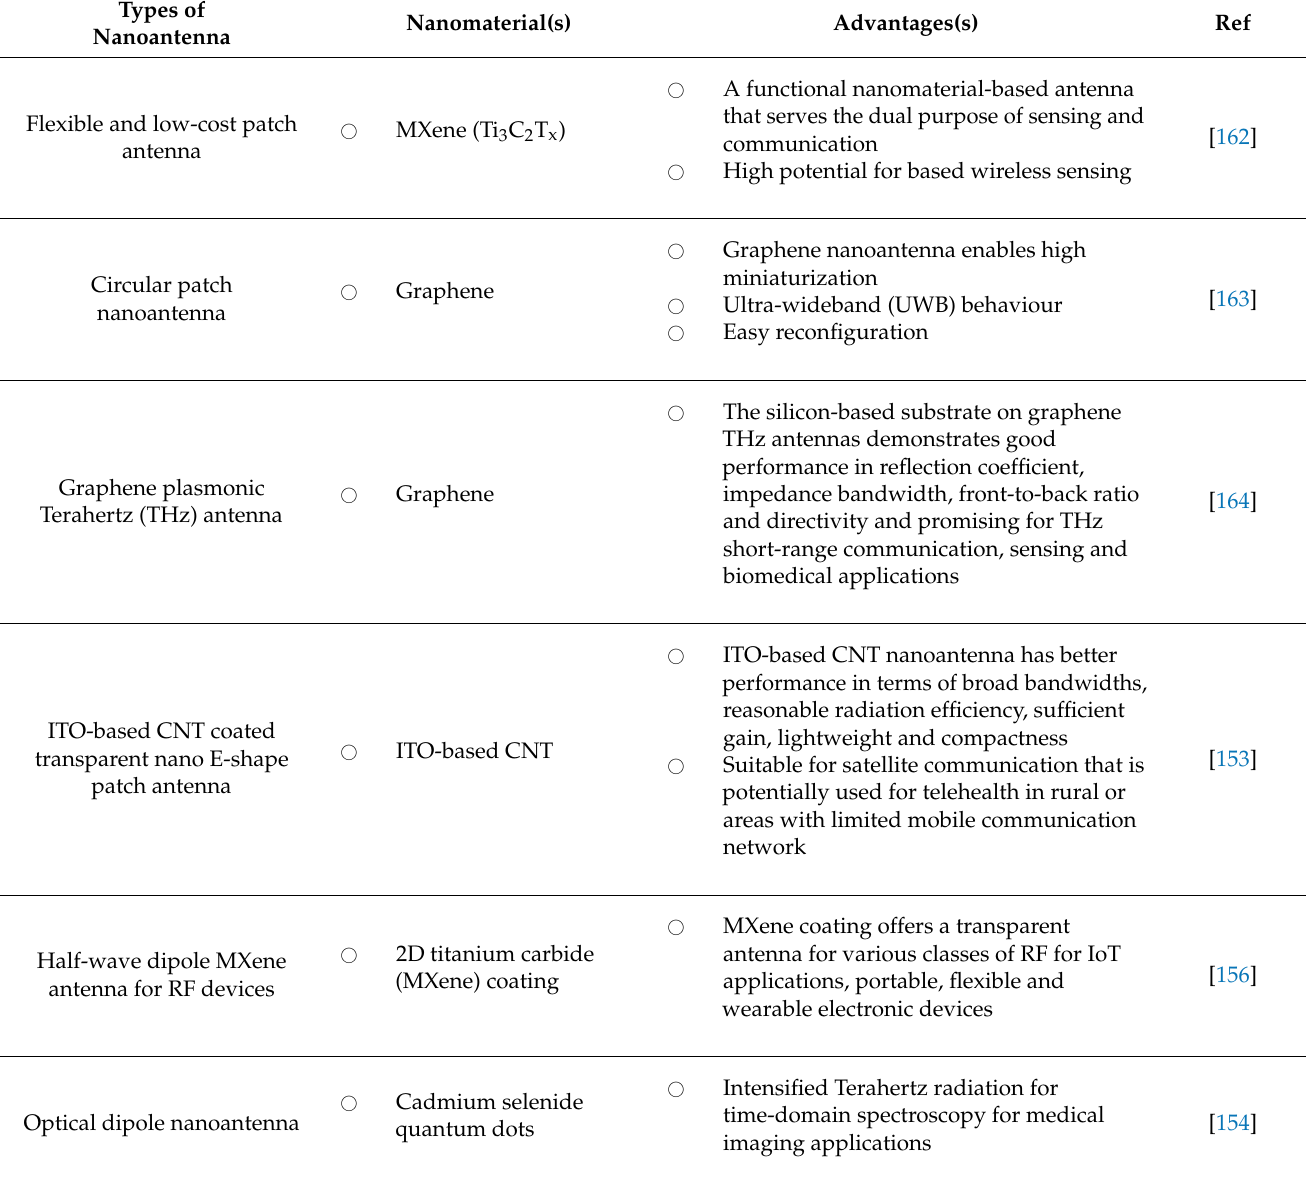
Table 4. Examples of nanomaterials-based nanoantenna and its advantages for wireless communica-